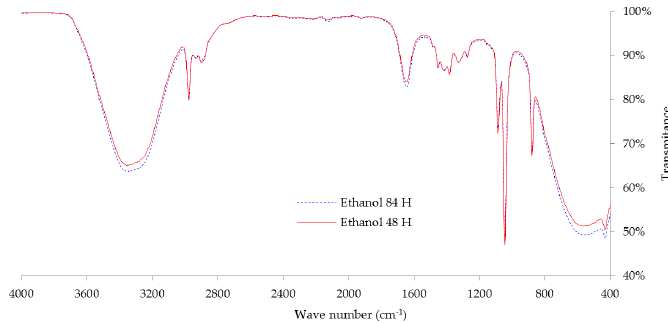
Figure 5. Fourier transform infrared spectrum of M. glaziovii bioethanol.